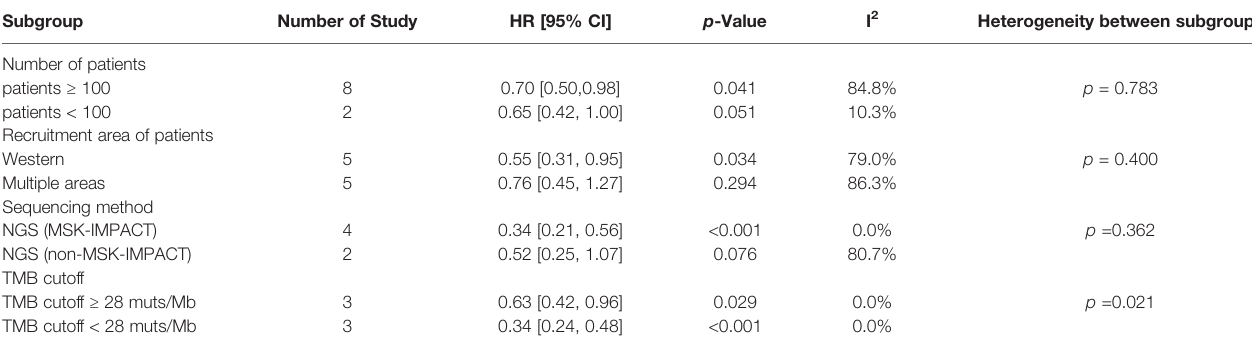
TABLE 2 | Subgroup analysis of overall survival between TMB-high and TMB-low group. Subgroup